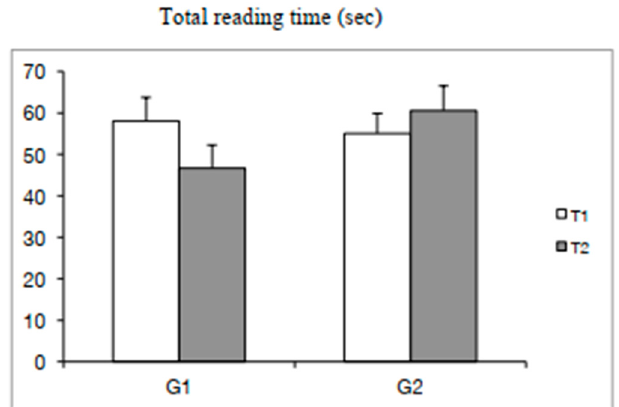
Figure 2. Means and standard deviations of the total time (s) of reading the text at T1 and T2 for both groups of children (G1 = experimental group; G2 = control group).